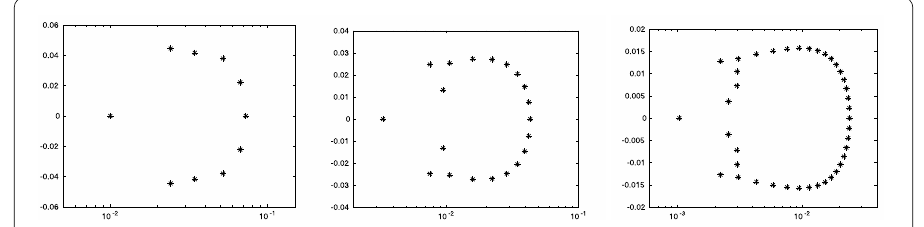
Figure 3 Eigenvalues of the matrix U n for a square-logarithmic weight function and n = 10,20,40 (from left to